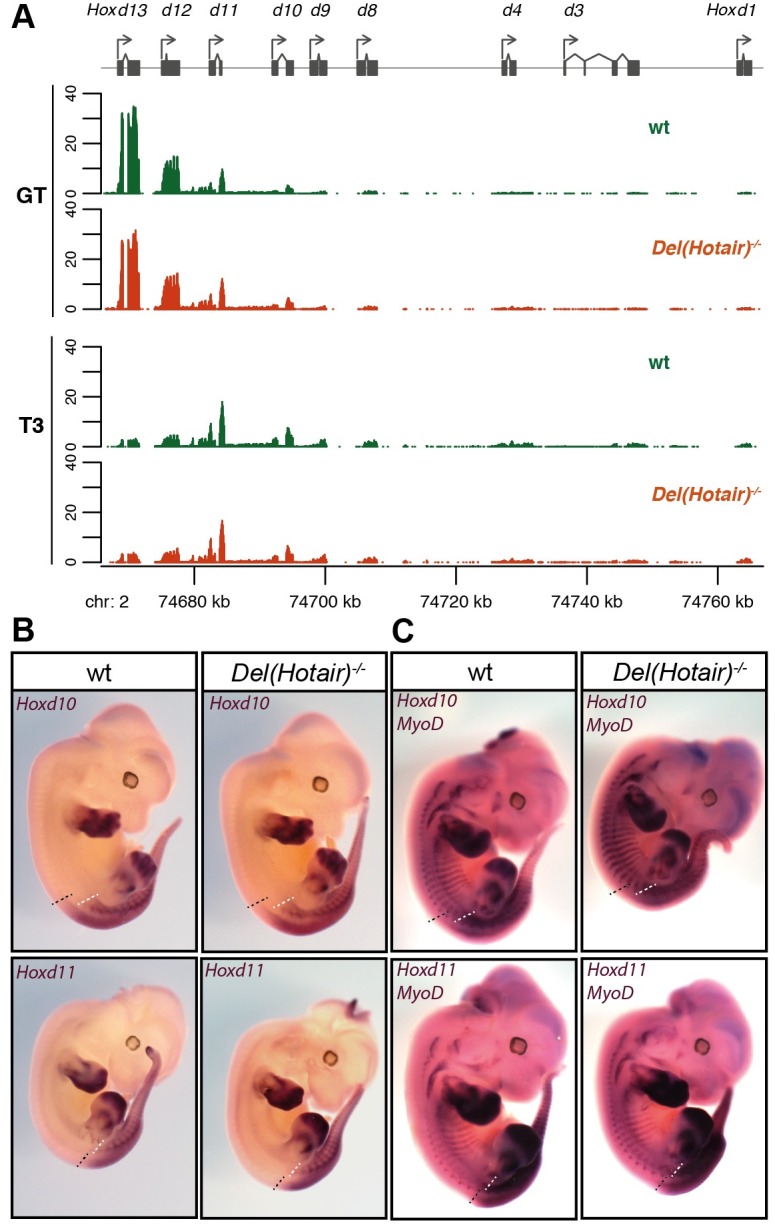
The deletion of Hotair does not alter Hoxd genes expression in embryo.(A) RNA-seq expression profiles of Hoxd genes in both the GT and T3 tissues of wild type (green) and Del(Hotair)-/- (orange) E12.5 embryos. The Y-axis represents the per-base read coverage, normalized by dividing by the total number of million mapped reads in the corresponding samples. The two biological replicates were pooled for this representation and only uniquely mapping reads were used. (B) WISH of Hoxd10 and Hoxd11 on E12.5 wild type (left) and Del(Hotair)-/- (right) embryos. The dashed lines indicate the rostral limits of the expression domains in the trunk, neural tube (black) and paraxial mesoderm (white). Adult vertebrae derive from the latter tissue. (C) Double WISH for the MyoD RNAs (for somite visualization) and either the Hoxd10 (upper panel) or Hoxd11 (lower panel) on E12.5 wild type (left) and Del(Hotair)-/- (right) embryos. There was no detectable difference in the anterior limit of expression for any Hoxd gene analyzed.